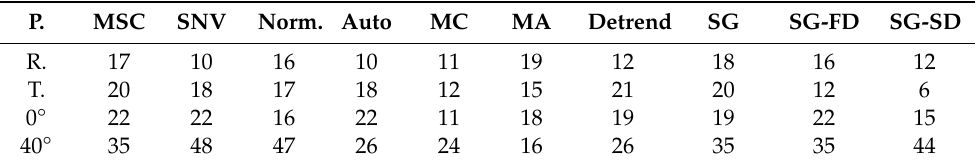
Table 4. Number of feature wavelengths extracted after successive projections algorithm (SPA) processing.